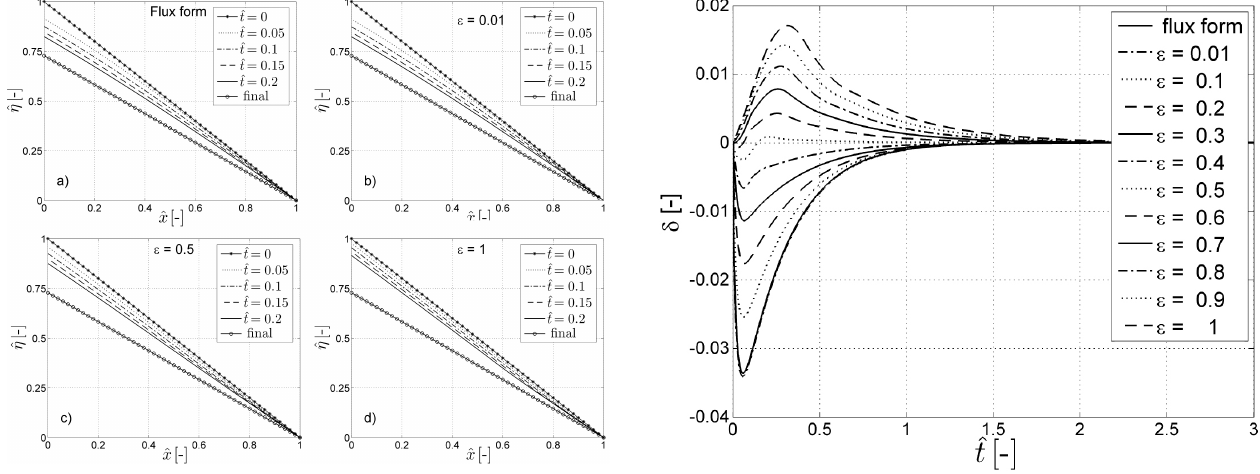
Figure 5. Bed profile evolution for the case ˆ E f = 1 / 2: (a) flux form; (b) entrainment form for ε = ¯ r / L d = 0 . 01; (c) entrainment form for ε = 0 . 5; and (d) entrainment form for ε = 1, using the thin-tailed exponential step length function of Eq. (8). As ε increases, the dif- ferences between the results from the two forms increase because of the nonlocality of particle movement, with an evolution from downward-concave transient profiles to upward-concave ones.